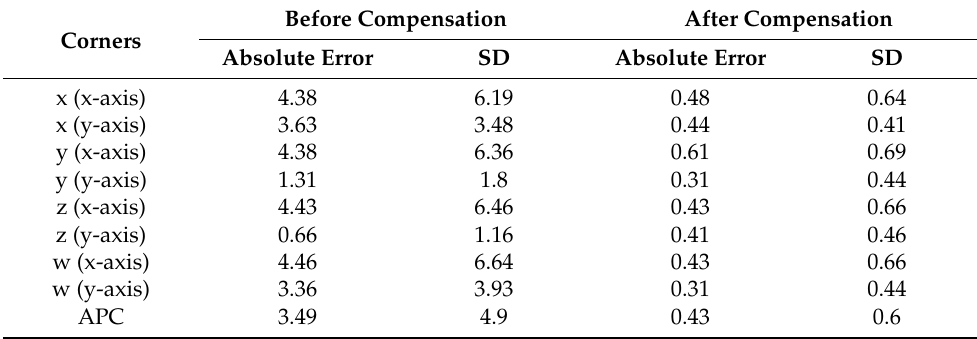
Table 3. Compensation results for each corner and average per class (APC).